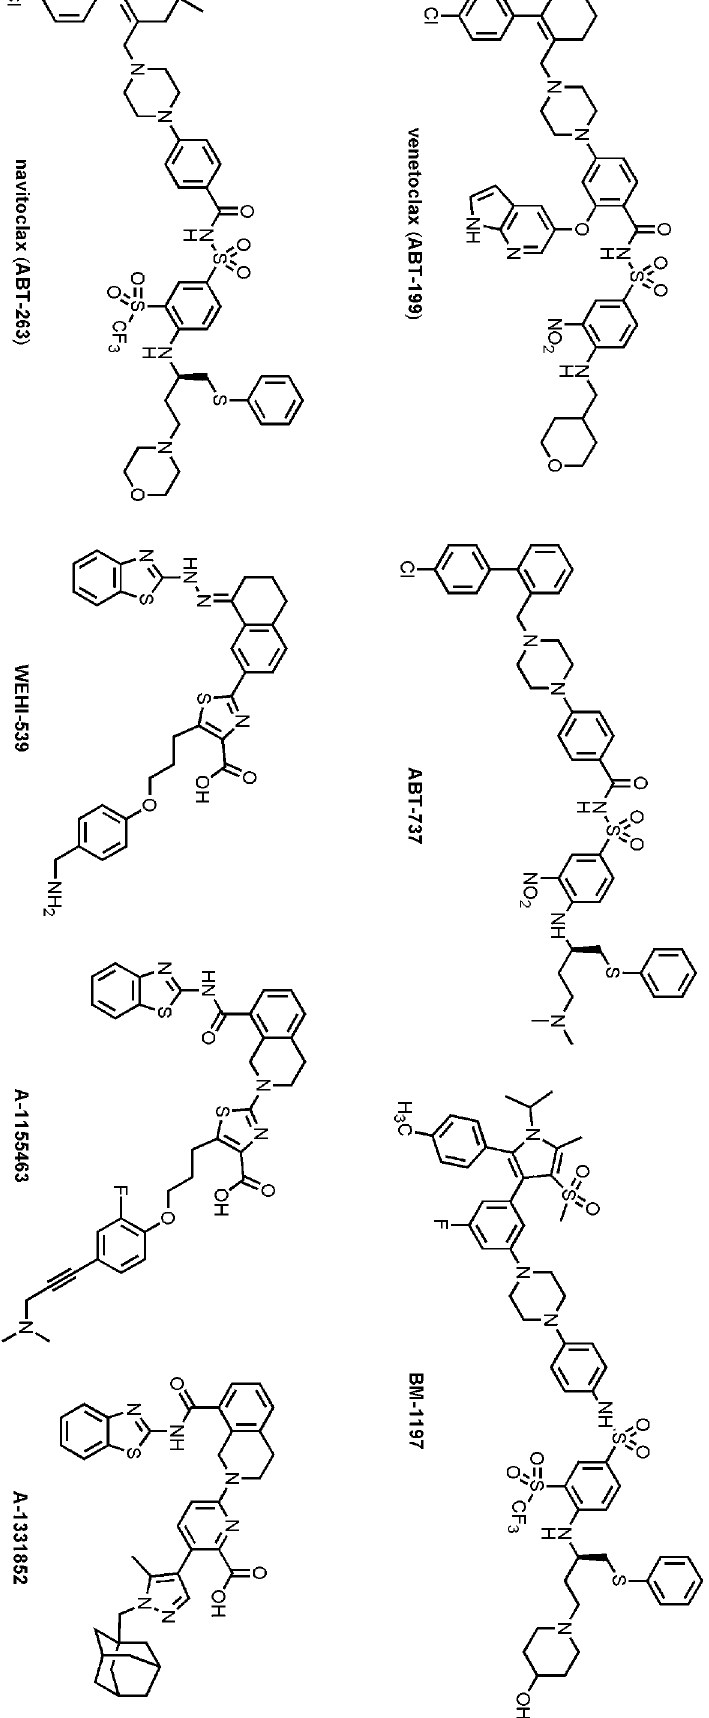
selective (WEHI-539, A-1155463, and A-1331852) and BCL-X L